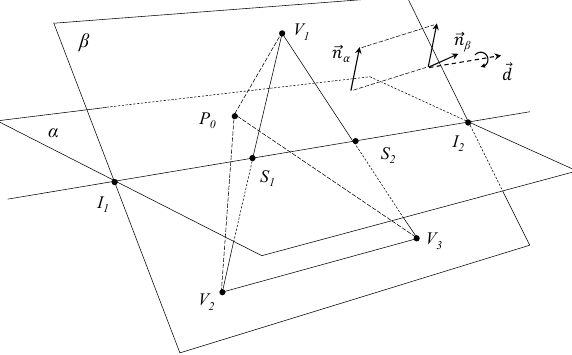
Figure 9. The intersection of a triangular facet with a cutting plane.